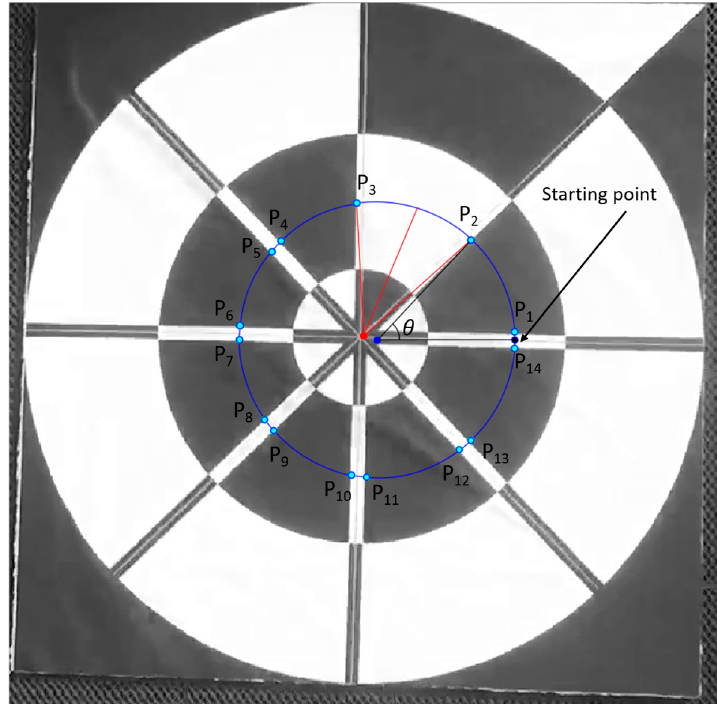
Figure 4. Predicted center and direction using our proposed method. Dark blue and red points respectively represent the positions detected by ATM and profile checker algorithm.